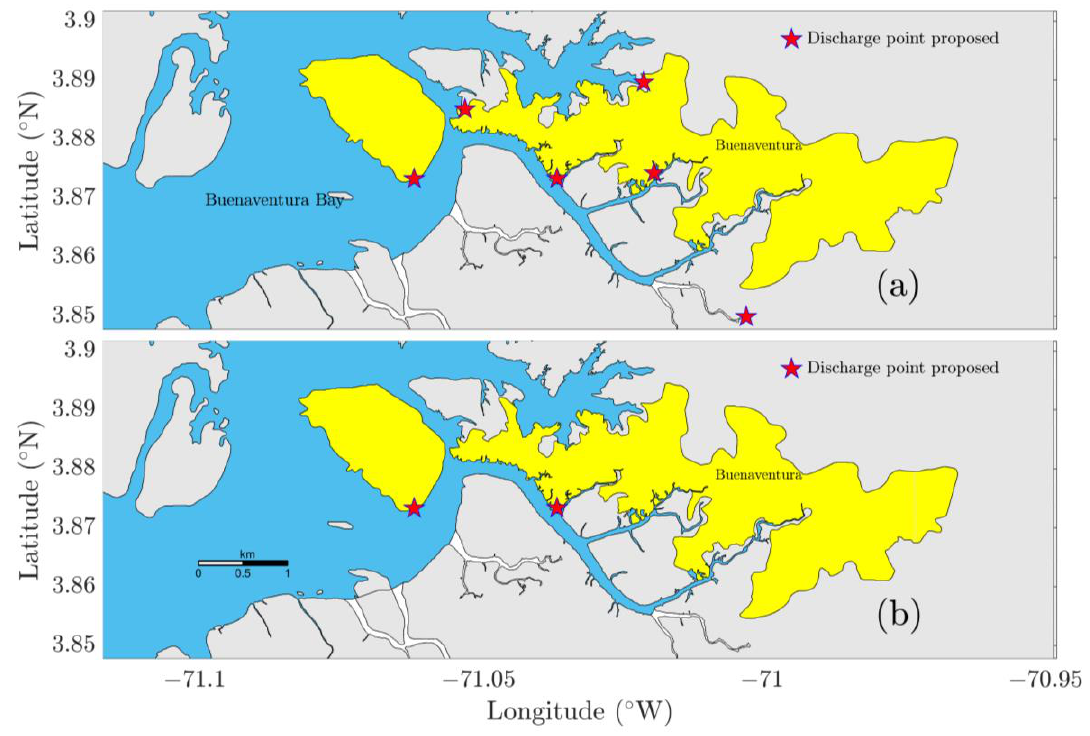
Figure 6. Discharge point in the scenarios proposed, ( a ) Scenario two; ( b ) Scenarios three and four .